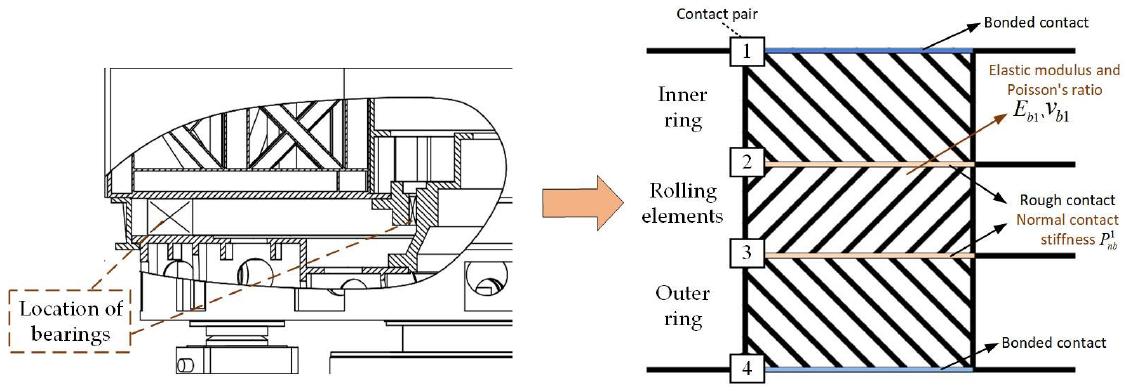
Figure 8. Schematic diagram of the contact pairs of a single-bearing unit.